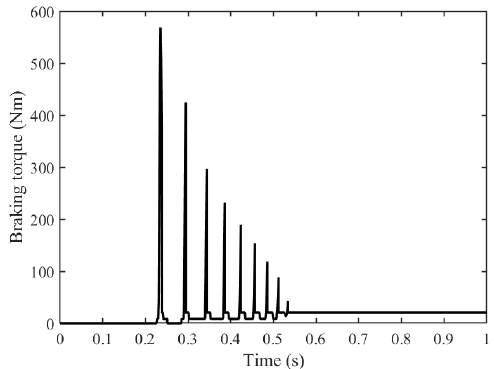
Figure 14. Dynamic features of friction pair under forward load.